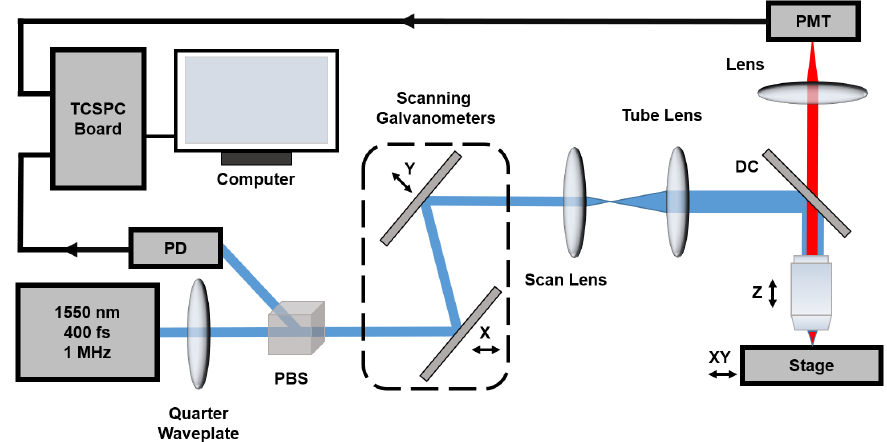
Scheme 1. Schematic illustration of 3PF lifetime microscopic imaging